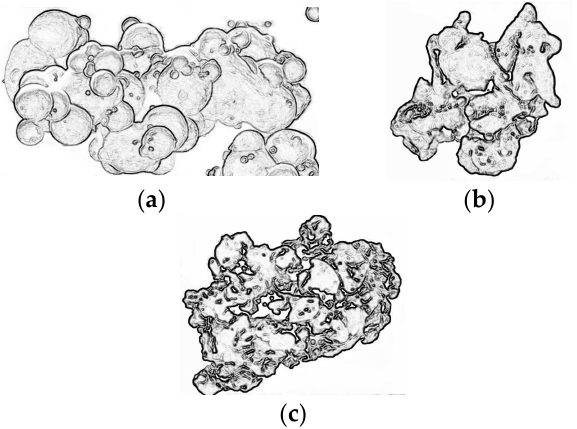
Figure 1. Examples of different agglomerates’ structures adapted from Refs. [19,24,25]. When the surface reaches the sticky state, collisions with other particles (sticky or dry) could lead to agglomeration, depending on velocity, particle momentum, collision angle, and time of contact between particles